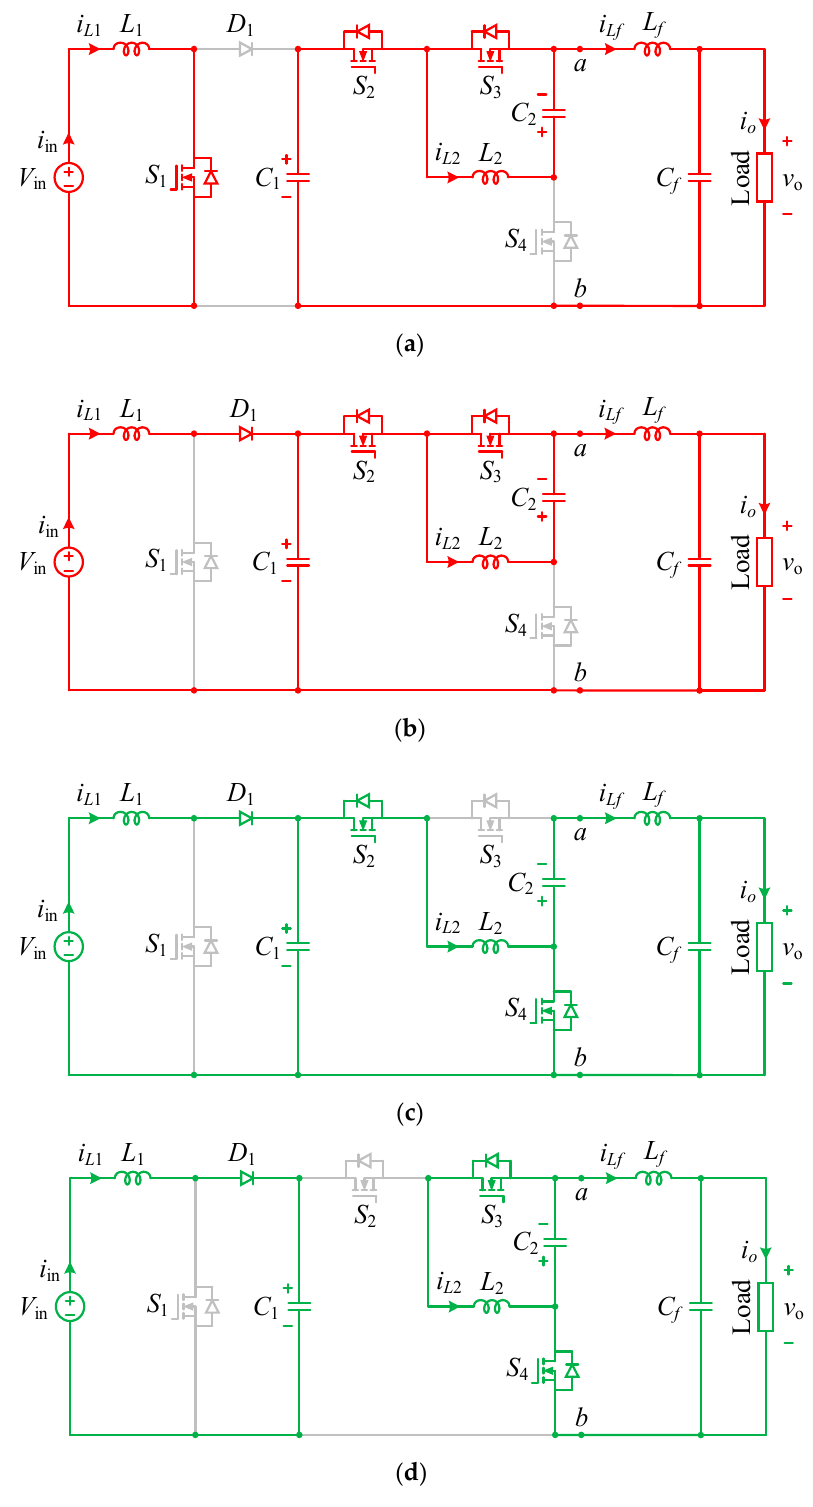
Figure 3. Circuit states of the proposed single-stage BB-BTI. ( a ) State 1 of boost mode, ( b ) State 2 of boost mode, and state 1 of buck mode, ( c ) State 1 of buck-boost mode, ( d ) State 2 of buck and buck-boost modes.